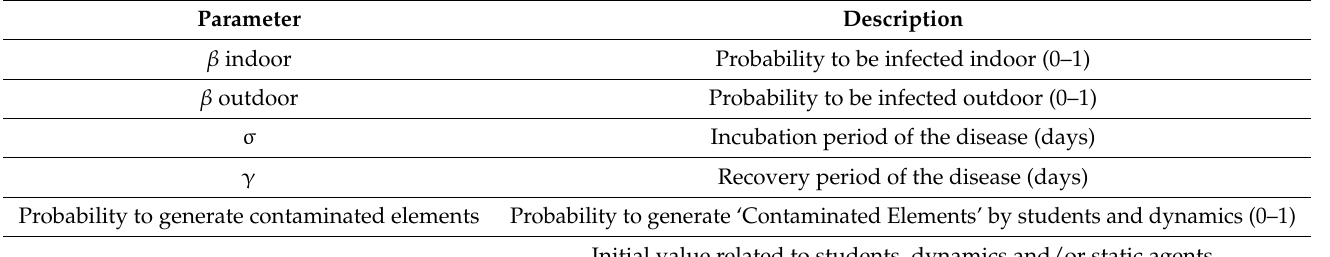
Table 5. ABM parameters related to the infectious disease to set up before